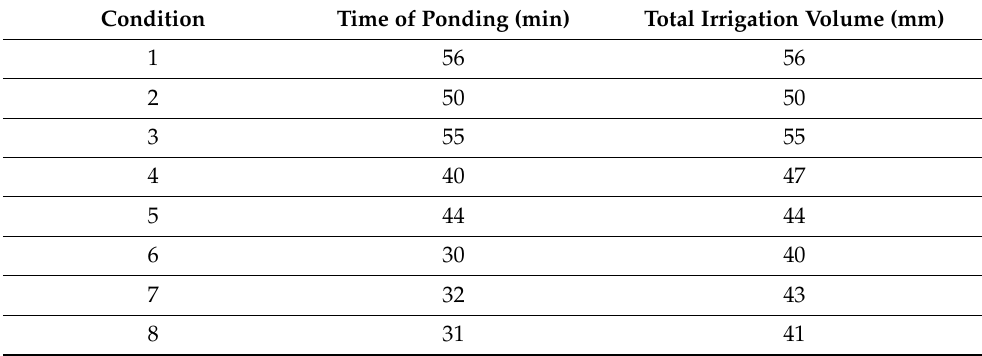
Table 6. Experimental results of water accumulation time.